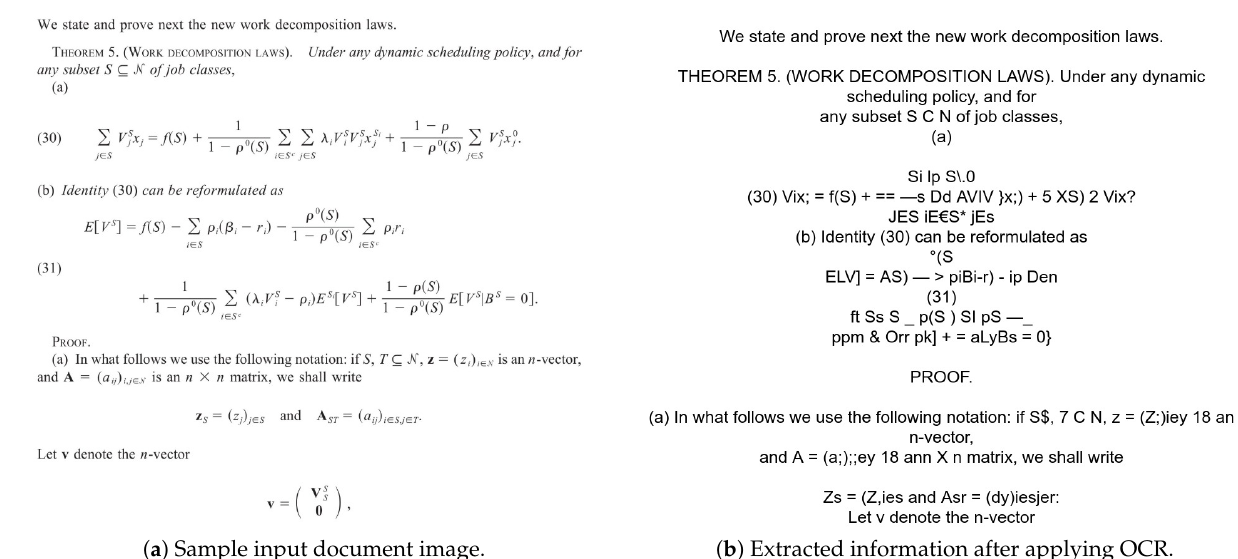
Figure 1. Visual depiction of the need to apply formula detection before extracting information in document images. We apply open source Tesseract-OCR [4] on a document image taken from Marmot dataset [9] containing mathematical formulas as illustrated in ( a ). Besides the textual content, the OCR system fails miserably in recognizing information from formulas as depicted in ( b ).